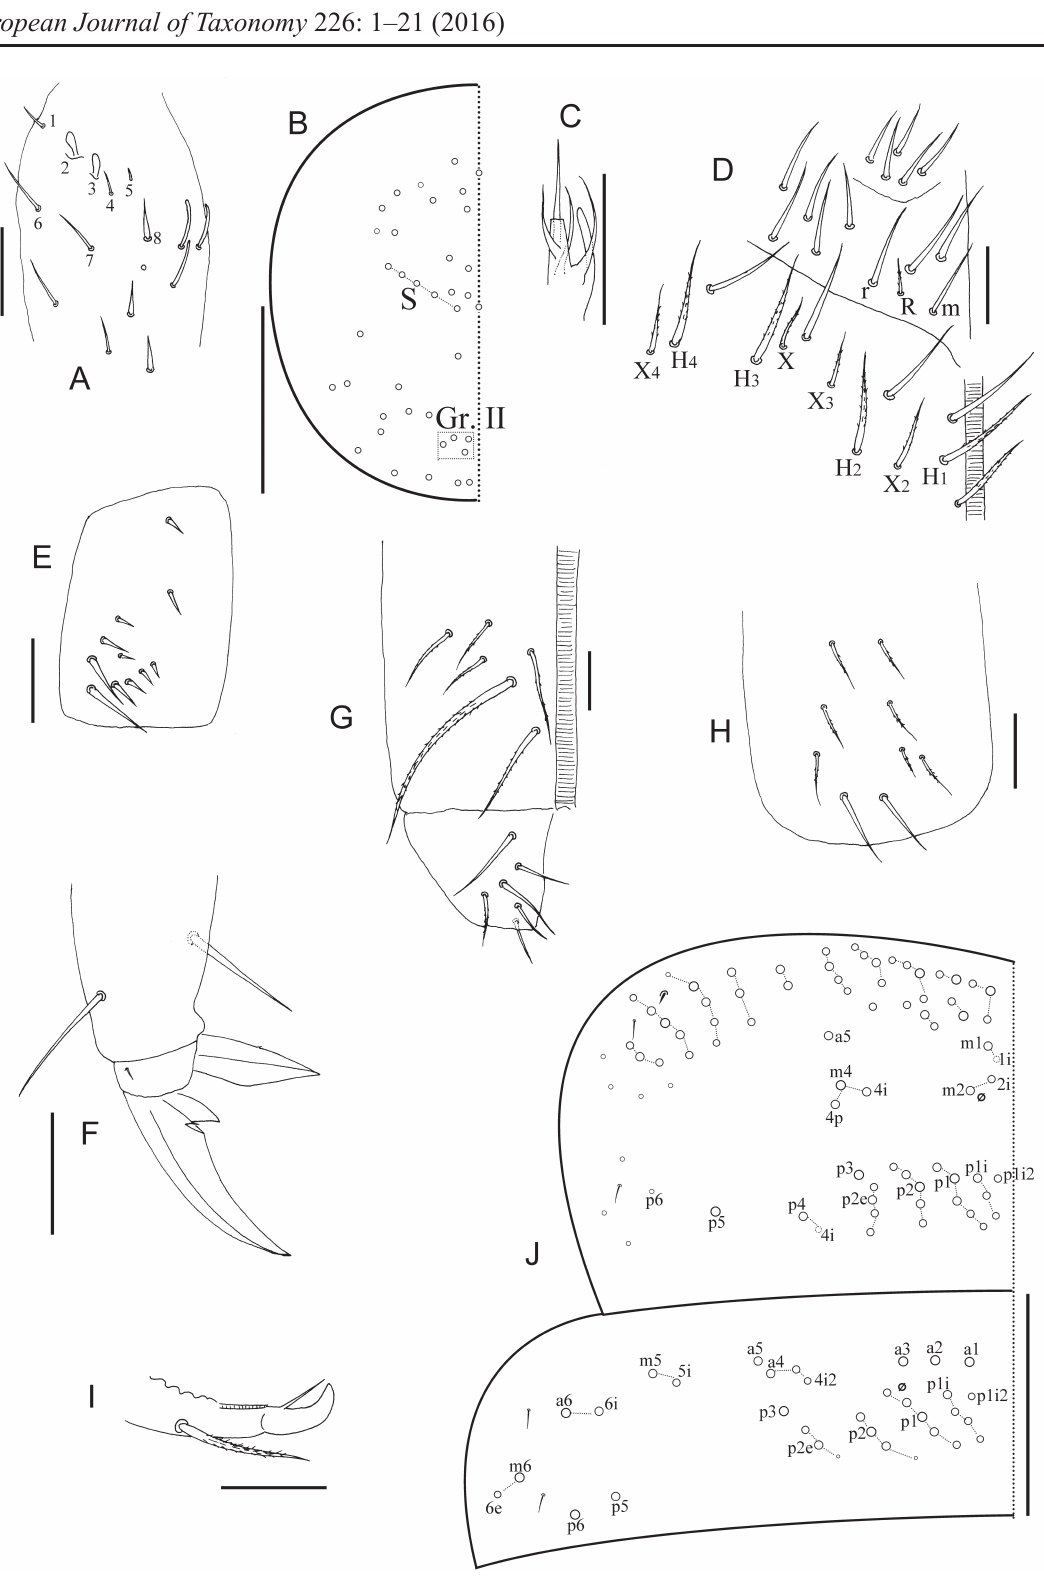
Fig. 6. Coecobrya ciliata sp. nov. A . Ant. III organ. B . Dorsal cephalic chaetotaxy. C . Lateral process of labial palp. D . Chaetae on the ventral side of head. E . Trochanteral organ, ventral view. F . Hind claw. G . Anterior face of ventral tube ad lateral flap. H . Posterior face of ventral tube. I . Mucro. J . Thoracic chaetotaxy. Scale bars: A, C‒I = 20 μm; B, J = 100